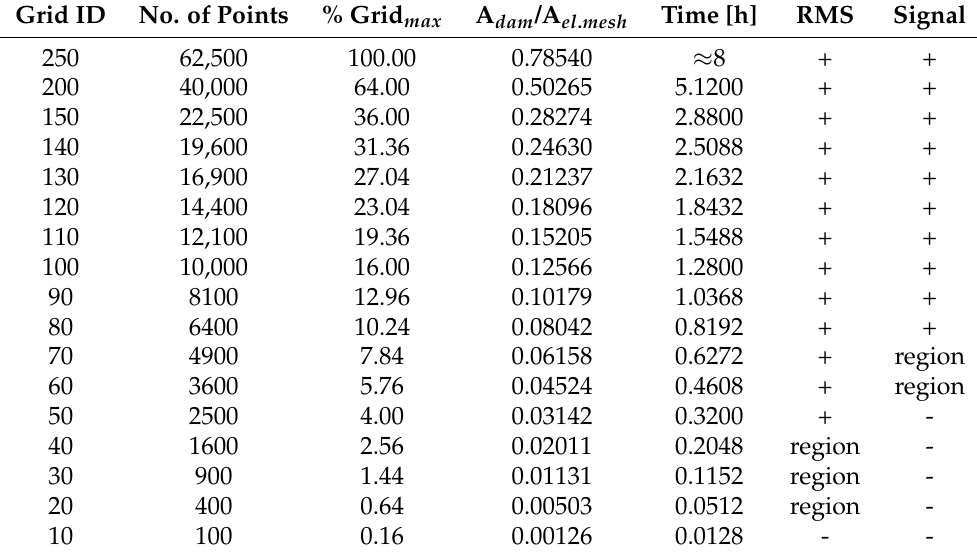
Table 2. Summary of damage localisation analysis in terms of number of measurement points, percentage measurement grid reduction and the change of damage